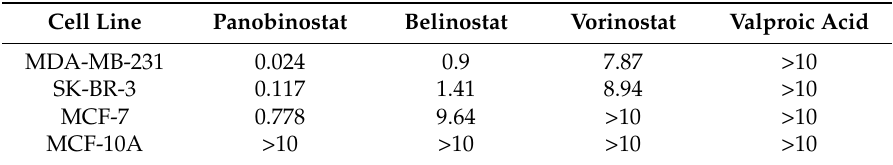
Table 1. The IC50 of cell viability by HADCi treatments on breast cancer and normal epithelia cells. Cell Line Panobinostat Belinostat Vorinostat Valproic Acid